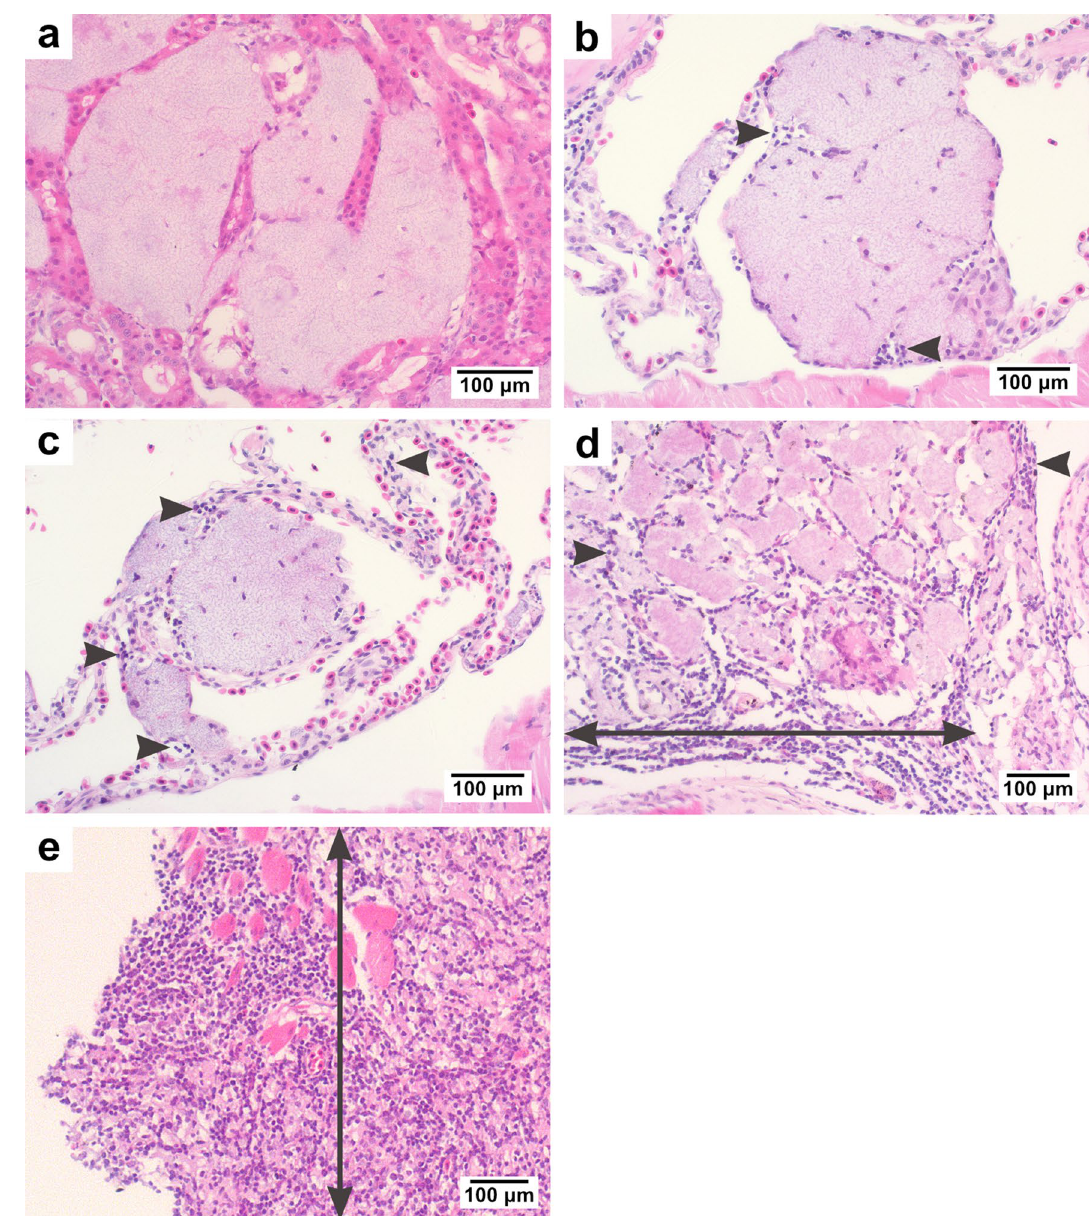
Figure 1. Histological sections stained with Haematoxylin and Eosin showing the range of inflammatory severity in Asian house geckos infected with E. lacertideformus . ( a ) Coalescing colonies of E. lacertideformus within the kidney associated with no inflammation (inflammatory score = 0), ( b ) large focal colony of E. lacertideformus in the lung containing mild inflammation adjacent to the bacterial colonies with perilesional cuffing (inflammatory score = 1, grey arrowheads), ( c ) focal colony of E. lacertideformus in the liver containing moderate inflammation adjacent to the bacterial colonies with perilesional cuffing and minimal inflammatory infiltrate (inflammatory score = 2, grey arrowheads), ( d ) multifocal colonies of E. lacertideformus markedly distending the soft tissues of the mandible and containing multifocal to coalescing inflammatory infiltrate with evidence of fibroplasia (inflammatory score = 3, double pointed arrow demonstrates location and range of inflammation), ( e ) dispersed colonies of E. lacertideformus replacing the soft tissue of the buccal subcutis or lamina propria and containing extensive and diffuse inflammatory infiltrates with evidence of fibroplasia (inflammatory score = 4, grey arrowheads, double pointed arrow demonstrates the location and range of